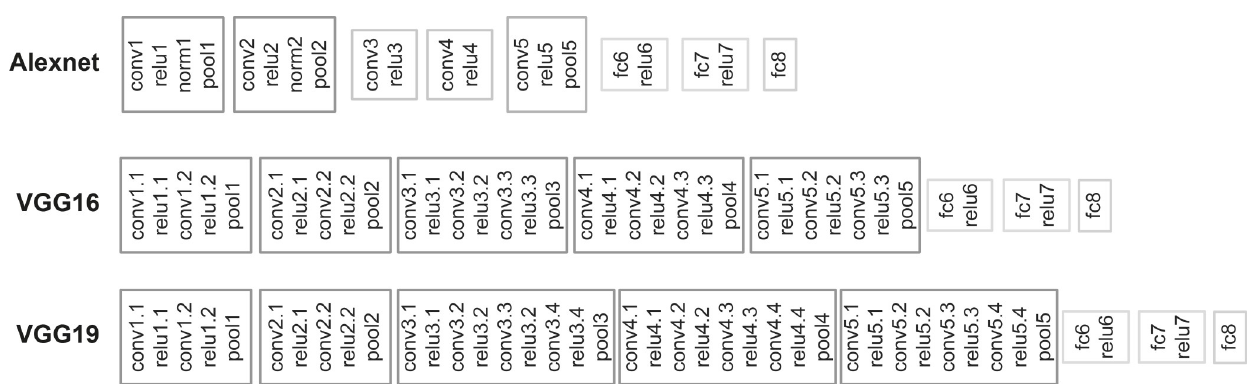
Fig 2. Model architectures. Deep Convolutional Neural Network (CNN) architectures for the 3 different networks that we employed: Alexnet, VGG-16 and VGG-19. Early computational blocks consist of consecutive operations such as: convolution (conv), RELU activation function, normalization (norm; only for Alexnet) and max pooling (pool). The later stages of each CNN incorporate three fully connected (fc) layers, where the first two are followed by a RELU activation function.